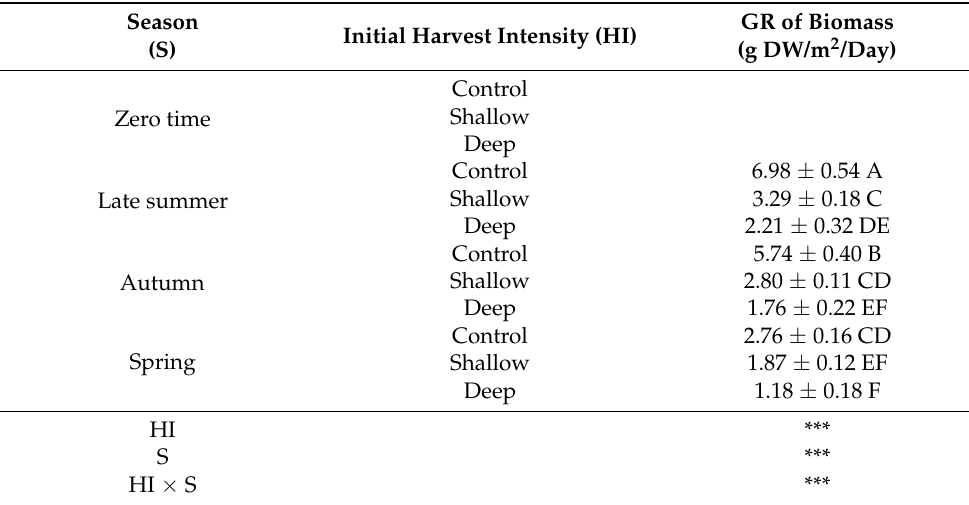
HI × S *** Values are presented as means ± SD ( n = 4). Mean values designated by a different letter are significantly different between groups (*** p < 0.0001, ** p < 0.001, * p < 0.05, NS = not significant), according to two-way ANOVA test with initial harvest intensity (HI) and season (S) as variability factors: initial harvest intensity (HI) for a, b, c and season (S) for x, y and z using lowercase letters, and initial harvest intensity (HI) × season (S) interaction for capital letters. The zero-time data was not included in two-way ANOVA test.